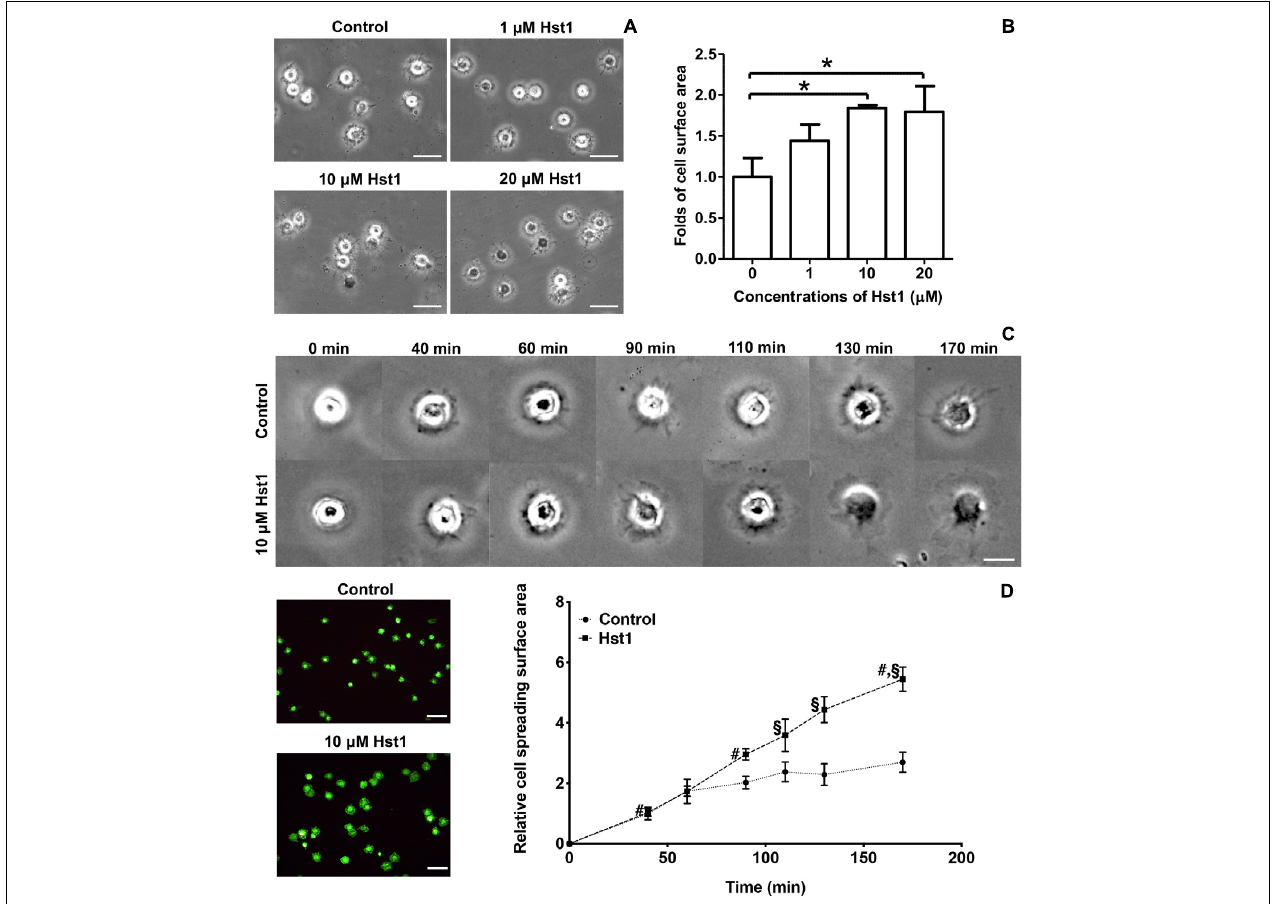
FIGURE 1 | Hst1 promoted the spreading of osteogenic cells on glass surfaces. (A) Light micrographs depicting the spreading of osteogenic cells in the absence or presence 1, 10, and 20 µ M Hst1. Bar = 50 µ m. (B) Folds of cell spreading surface area in the absence or presence or of 1, 10, and 20 µ M Hst1. Data are shown as mean ± SD ( n = 6). * p < 0.05 (C) Light micrographs of the spreading of osteogenic cells in the absence or presence of 10 µ M Hst1 on different time points. (D) Fluorescent micrographs depicting the spreading of osteogenic cells (stained with FITC-Phalloidin) in the presence or absence of 10 µ M Hst1 on bio-inert glass surface. Time-dependent cell spreading surface area (expressed in folds with the value of the control group at first time point as 1) in the presence or absence of 10 µ M Hst1. Data were shown as mean ± SD ( n = 6). § p < 0.05 indicating a significant difference compared with the values in the control group at the same time point; # p < 0.05 indicating a significant difference compared with the value in the same treatment group at the earlier time point. Bar = 50 µ m.